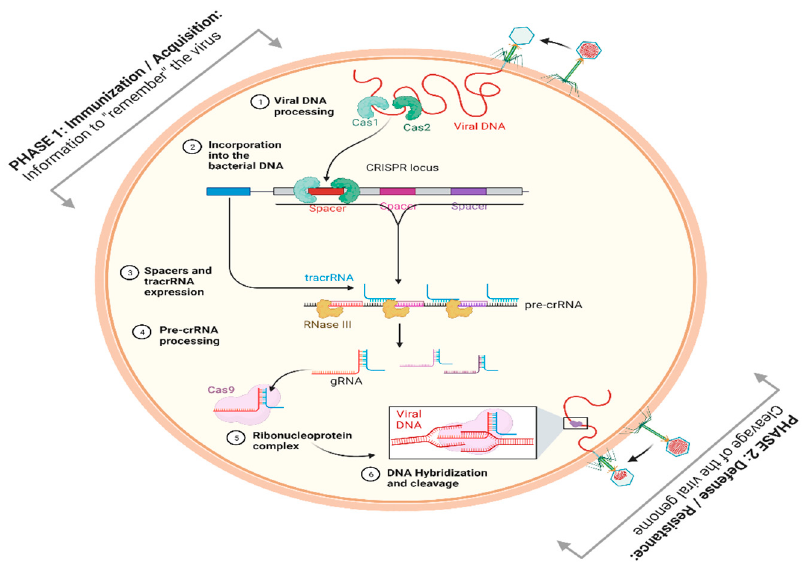
Figure 1. Schematic representation of CRISPR/Cas9 adaptive immune system. Adopted from Ghorbani et al. [9].